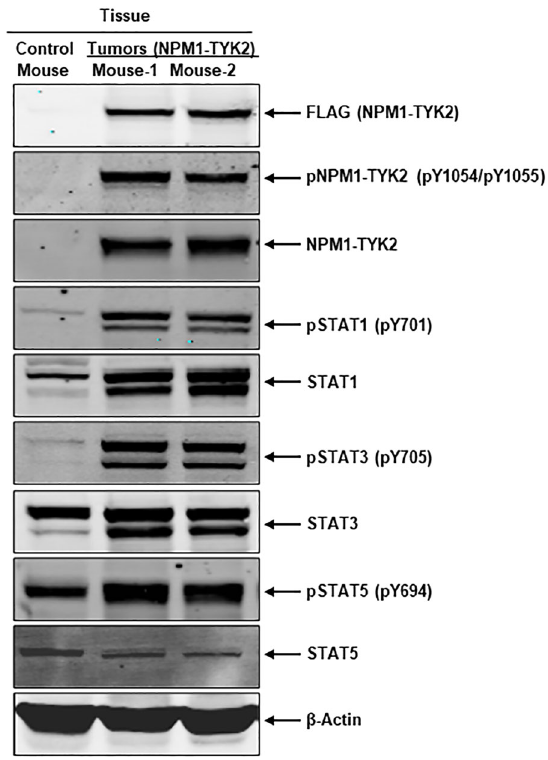
Fig. 6 Fusion kinase NPM1 – TYK2 constitutive activation drives tumorigenicity in in vivo xenograft models. Representative lysates were made from tissue collected from Ba/F3-Vector and transformed Ba/F3 – NPM1 – TYK2 injected mice. Western blot analysis was performed for NPM1 – TYK2 (FLAG), phospho-NPM1 – TYK2, phos- pho-STAT1/3/5, and respective total proteins. β -Actin served as an internal